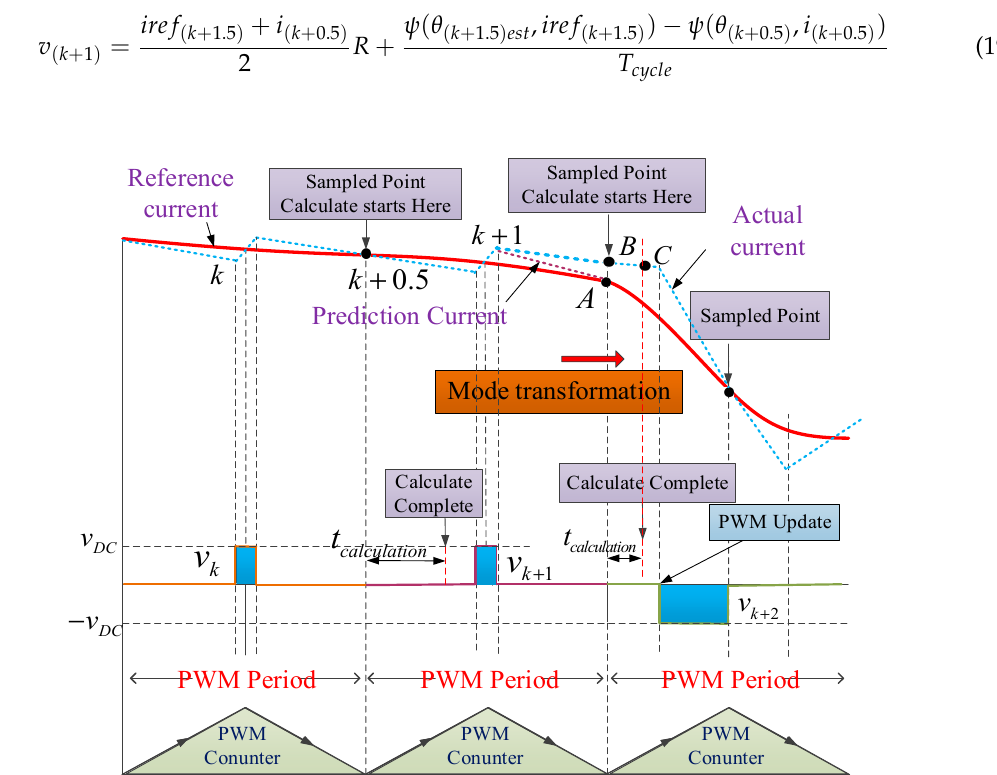
Figure 5. Duty ratio predicted at Transformation from excitation-freewheeling mode to demagnetization-freewheeling mode.